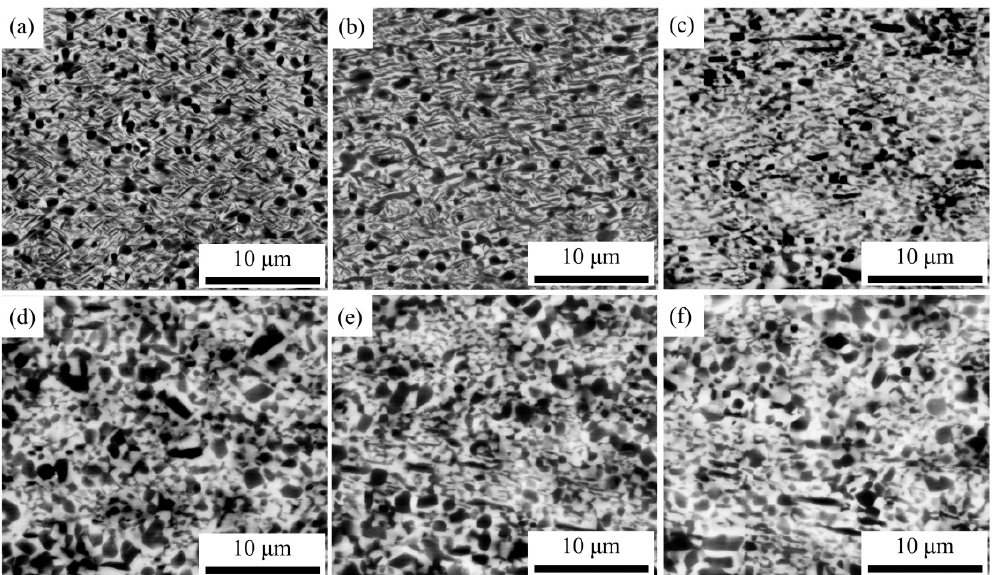
Figure 3. SEM images for the as-rolled and can-compressed samples with different height reductions: